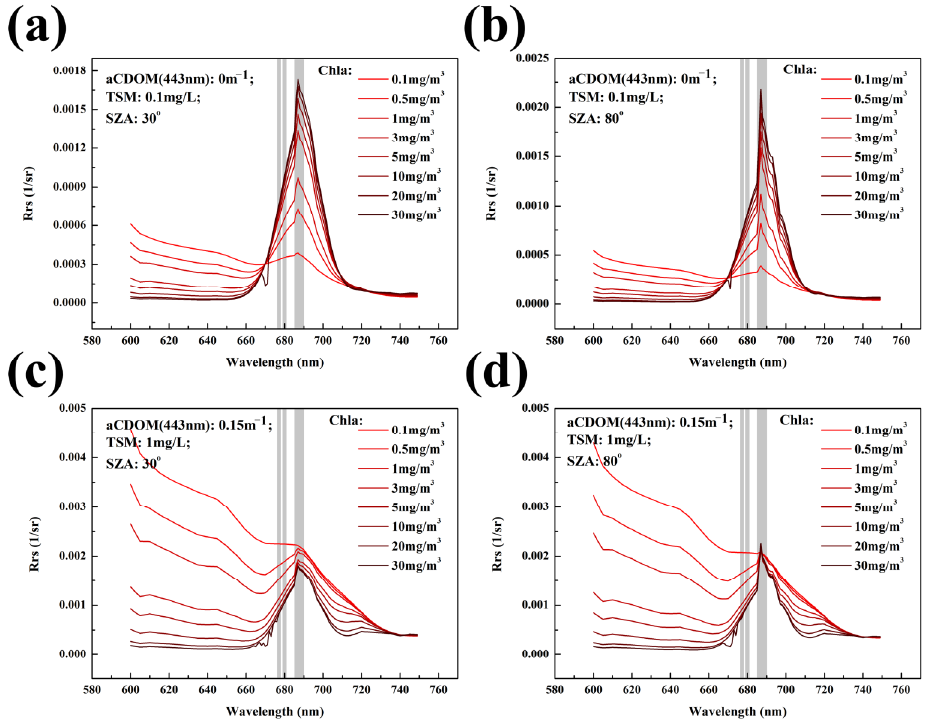
Figure 5. Effects of different zenith angles and different Chla concentrations in ( a , b ) clear ocean water bodies and ( c , d ) continental shelf water bodies. The three gray histograms denote the positions of the 678, 680, and 685–690 nm bands, respectively.